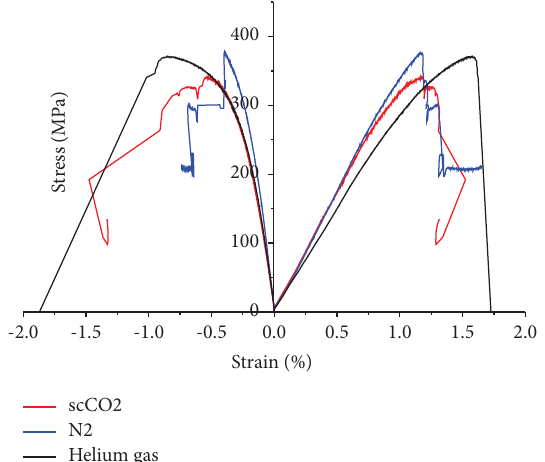
Figure 7: Stress-strain curves at the coring angle of 30 °